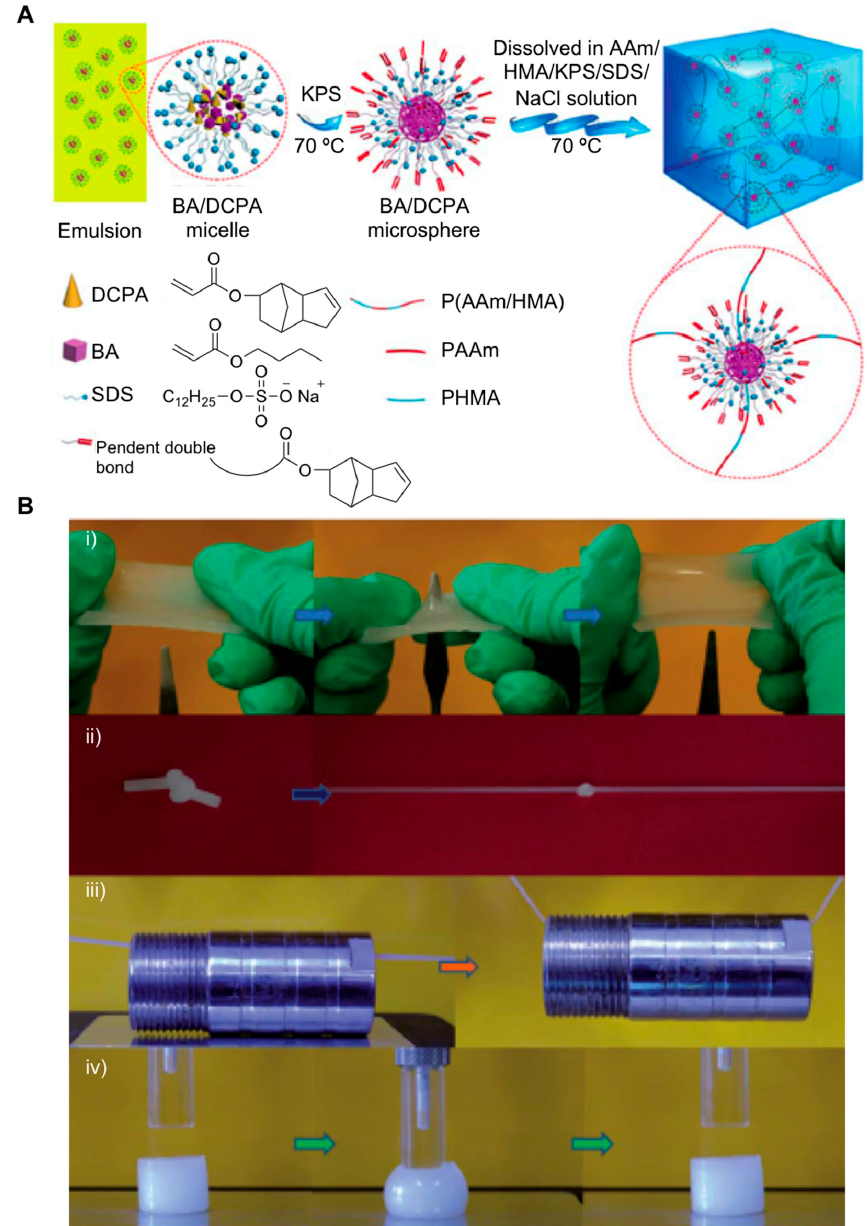
Figure 7. ( A ) Structure and formation mechanism of cross-linked P(AAm/HMA) hydrogels. ( B ) Demonstration of the toughness of macromolecular (MM) cross-linked P(AAm/HMA) hydrogels through ( i ) stabbing; ( ii ) knotted stretching; ( iii ) loading and ( iv ) compressing experiments (MM content was 1.0 wt.% of added monomers and the diameter was 349 nm after adding monomers). Adapted with permission from Reference [55]. Copyright 2016 Royal Society of Chemistry.